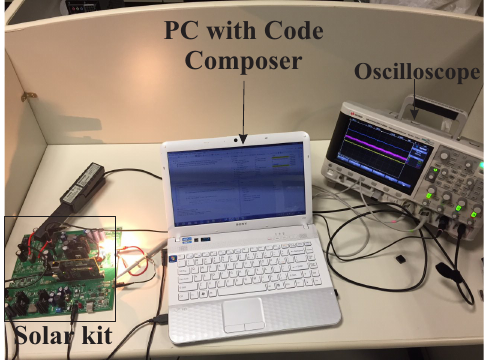
Figure 6. Experimental bench.